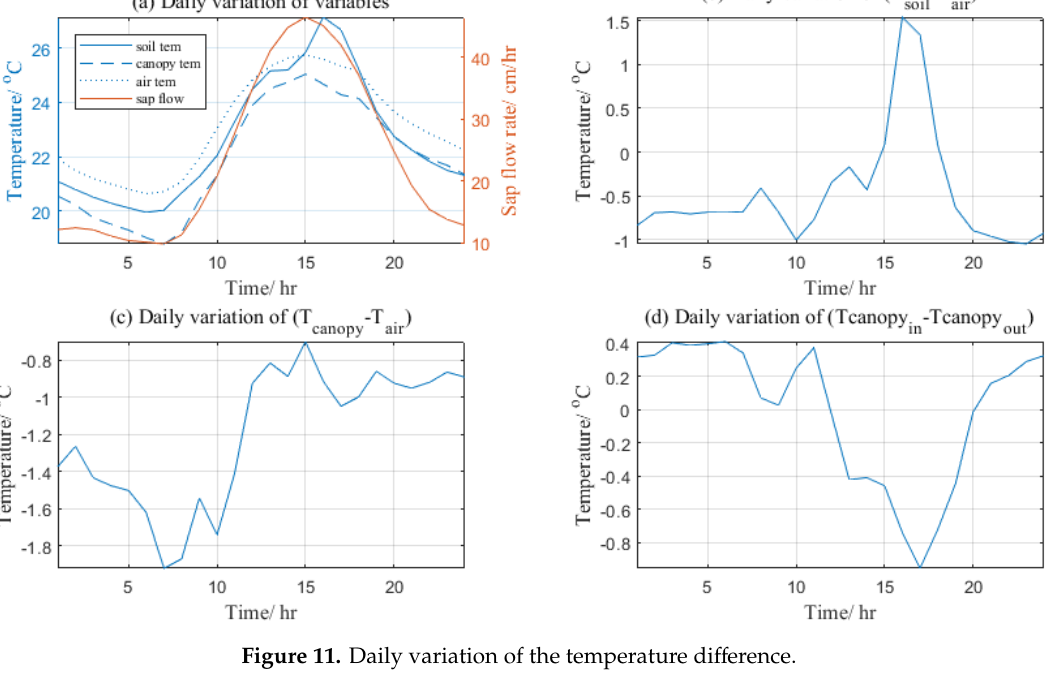
Figure 11. Daily variation of the temperature difference.